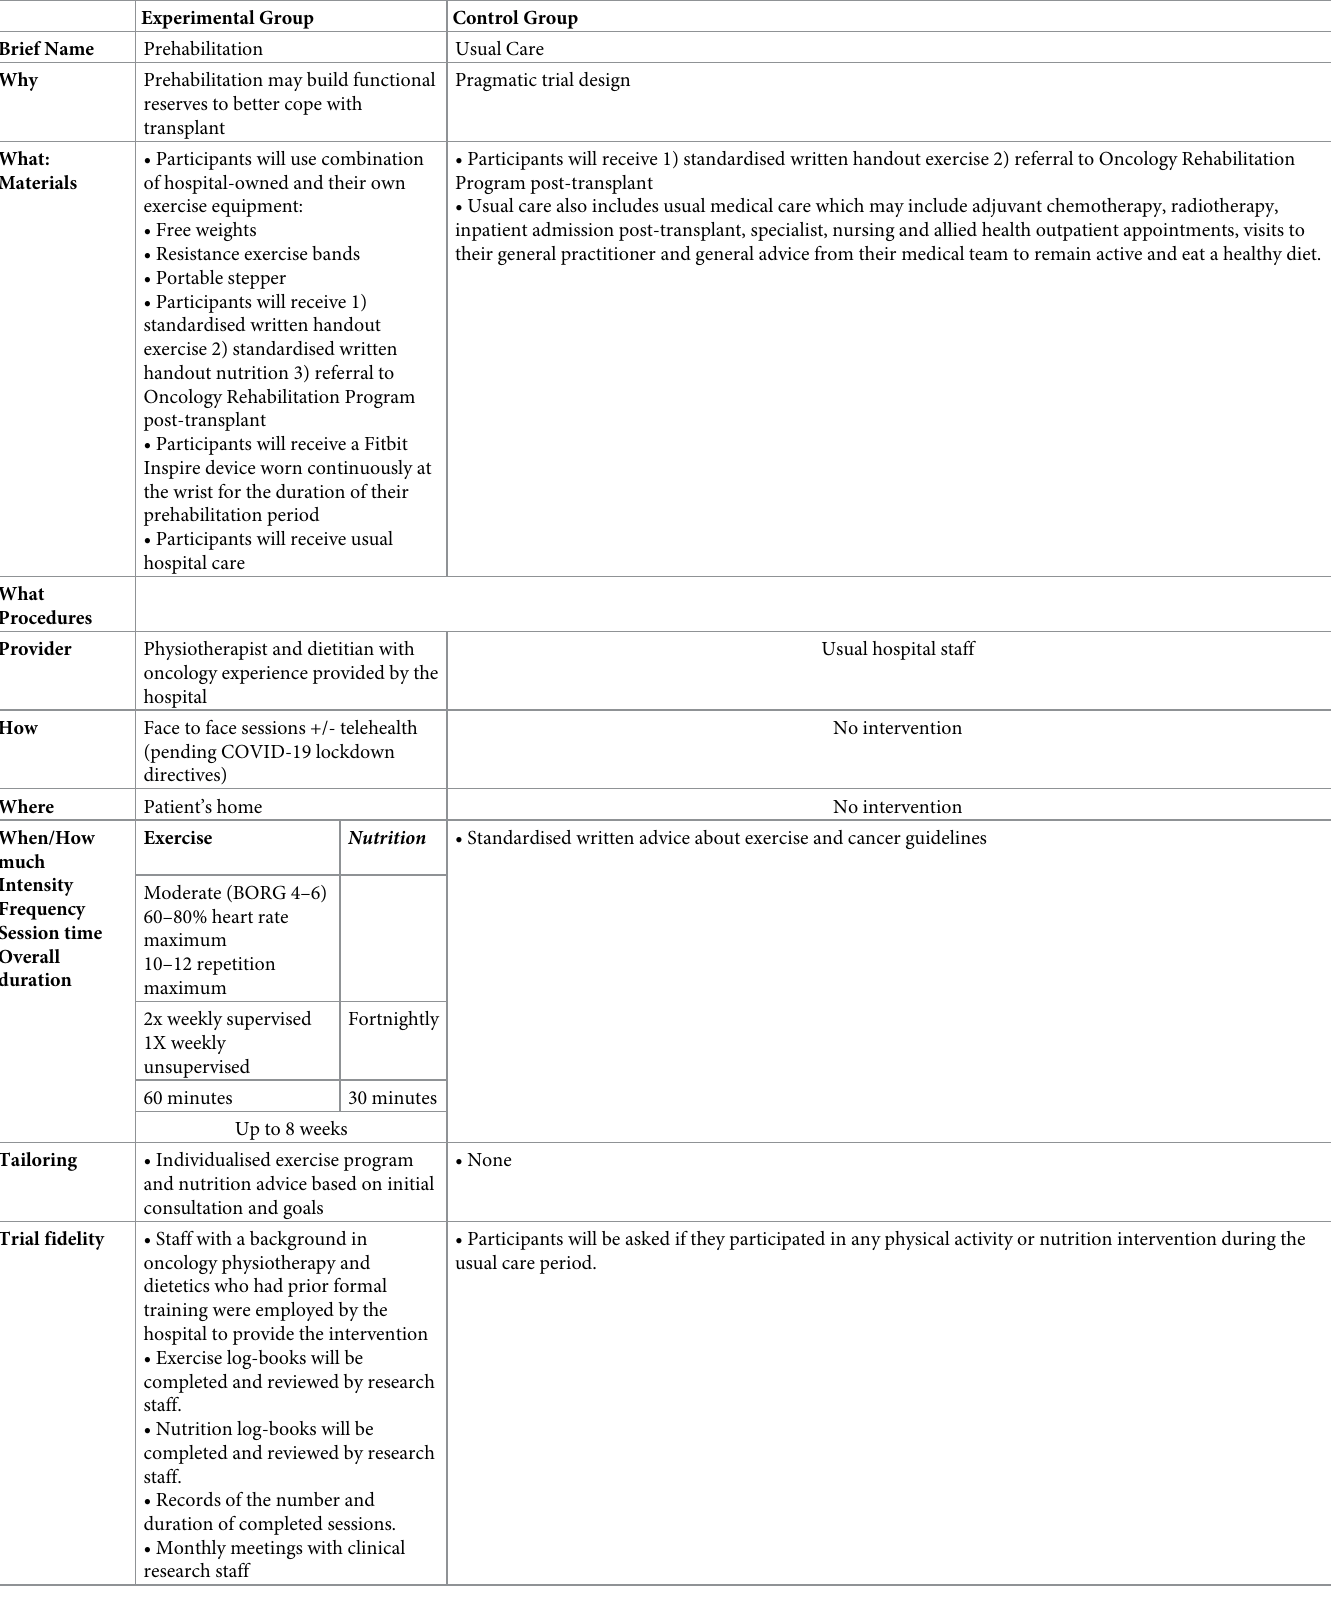
Table 1. Intervention description using the template for description and replication checklist